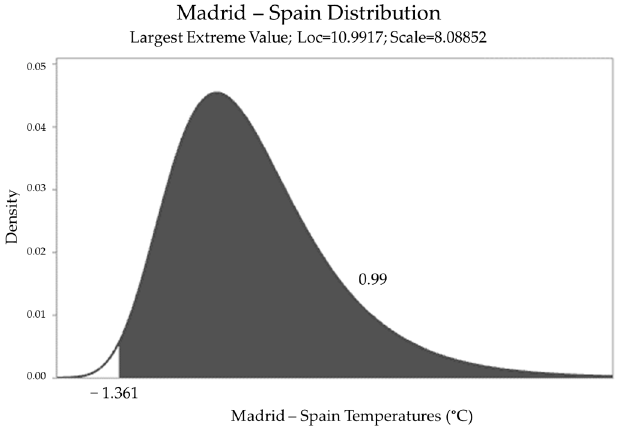
Figure 7. Madrid—Spain distribution.